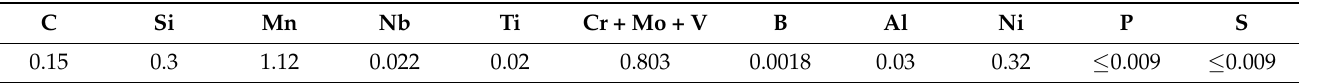
Table 1. Chemical composition of experimental steel.